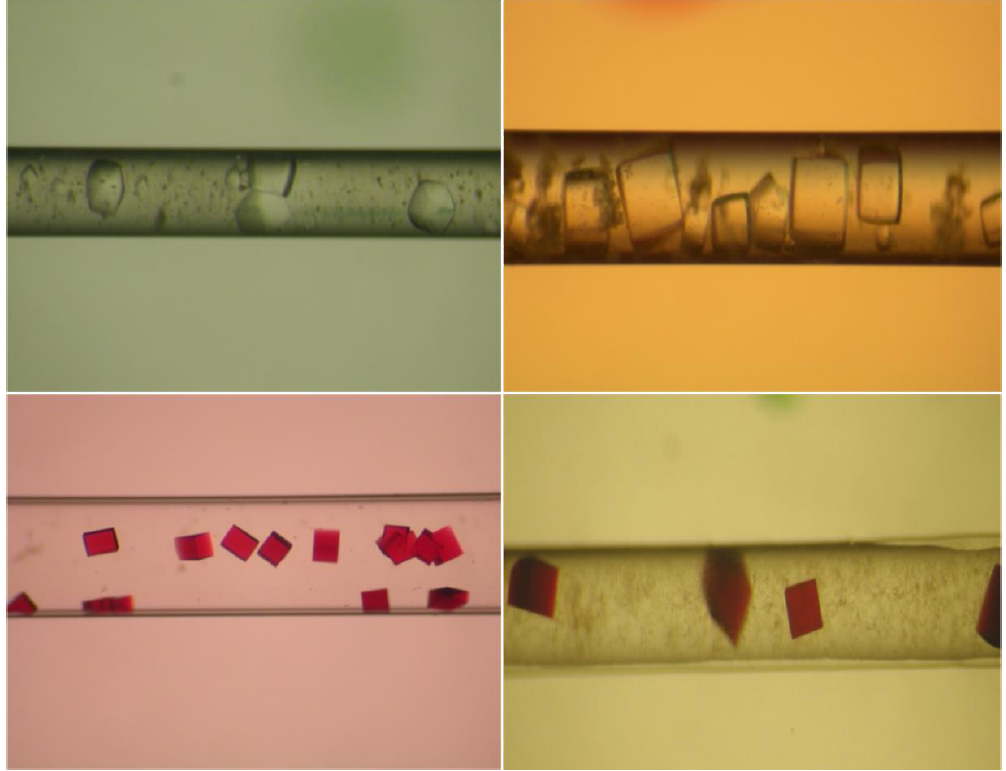
Figure 2. Pictures showing crystals of insulin (top, Φ inner = 0.5 mm) and cyano-HbII-III (bottom, Φ inner = 0.7 mm) proteins gown in space (left) and on-ground in agarose gel (right) environments,